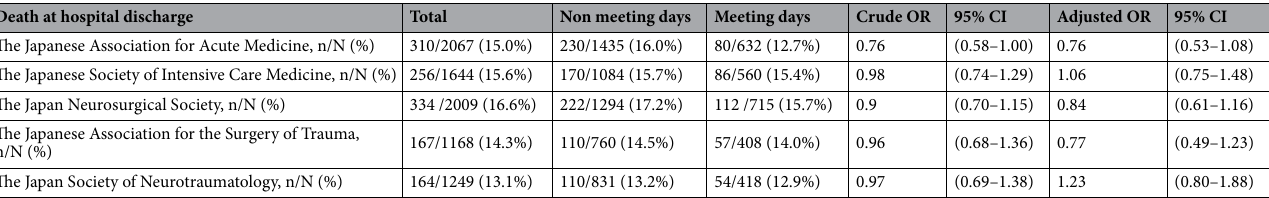
Table 3. Primary Outcomes between meeting days and non-meeting days as per the type of national meeting. OR odds ratio, CI confidence